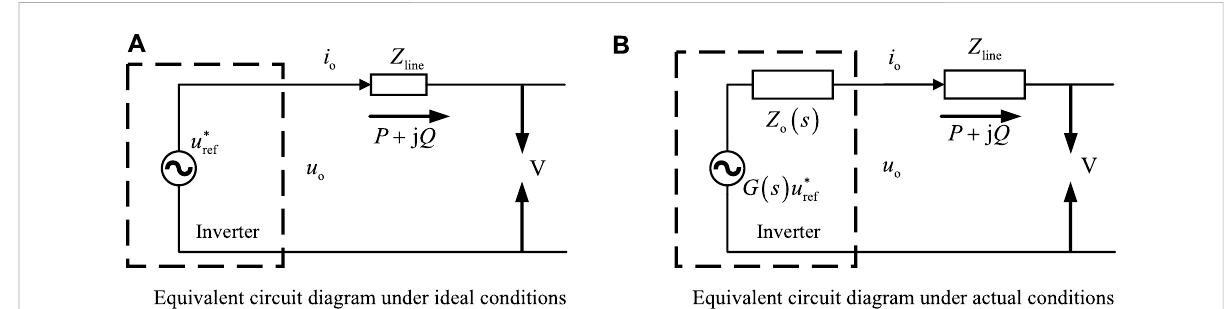
FIGURE 3 Idealandactualequivalentcircuitdiagramsbeforeaddingvirtualimpedance. (A) Equivalentcircuitdiagramunderidealconditions (B) Equivalent circuit diagram under actual conditions.